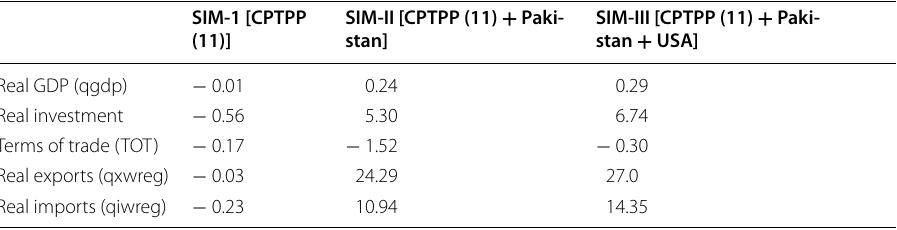
Table 3 Impact of TPP on macroeconomic variables of Pakistan Source : Author’s